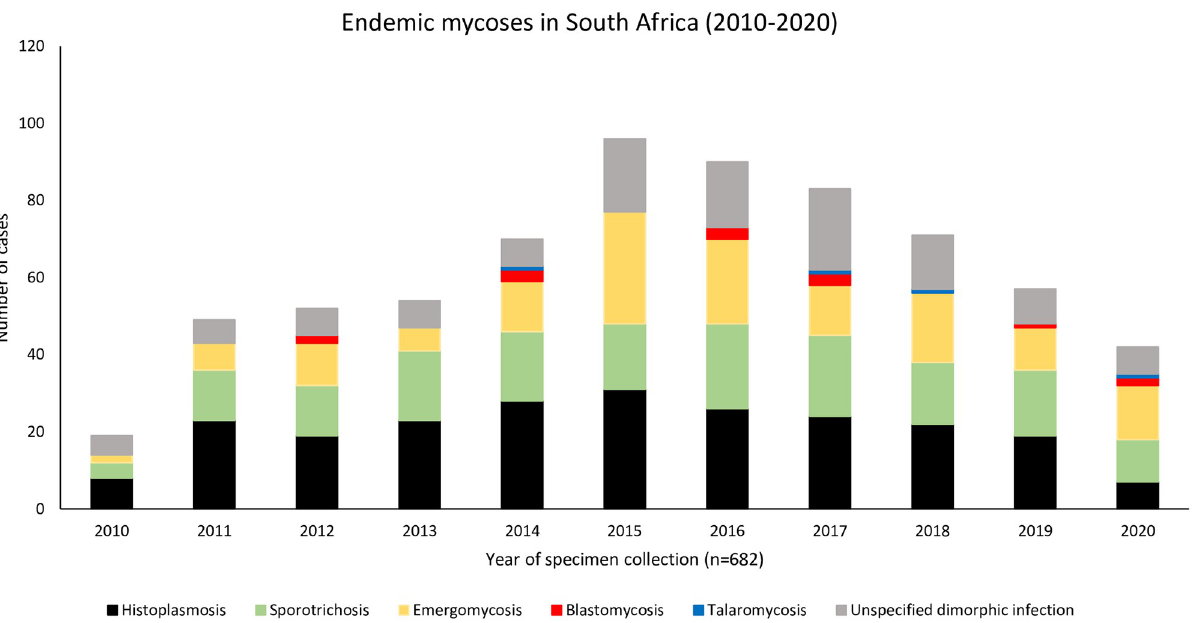
Fig 1. Frequency of laboratory-diagnosed endemic mycoses (proven, probable and possible) per year in South Africa from 2010–2020, n = 682.